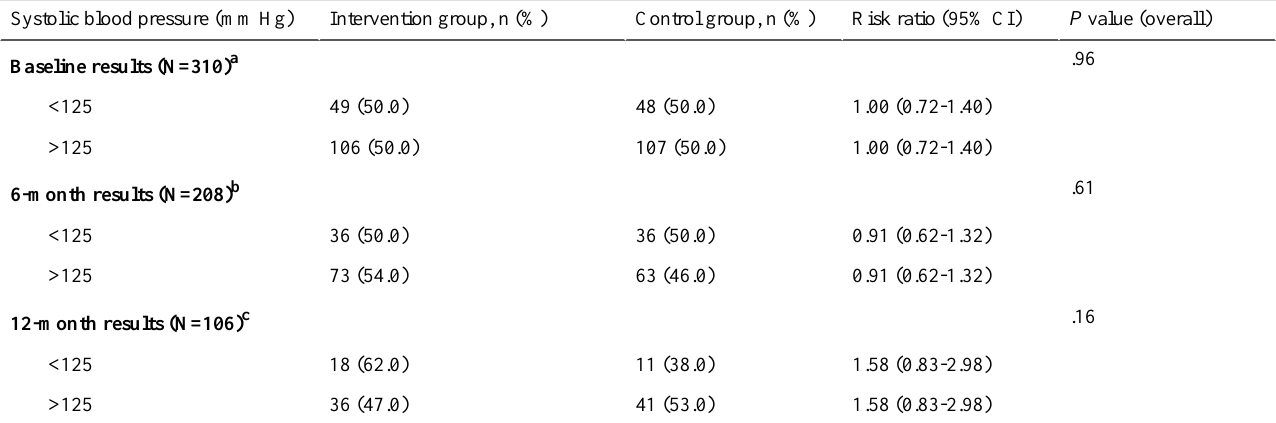
Table 2. Systolic blood